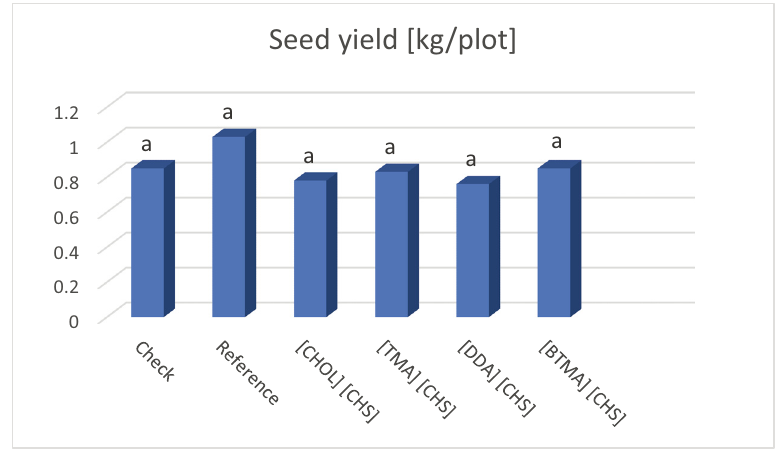
Figure 7: In fl uence of the tested ILs on seed yield ( kg/plot ) of fi ber